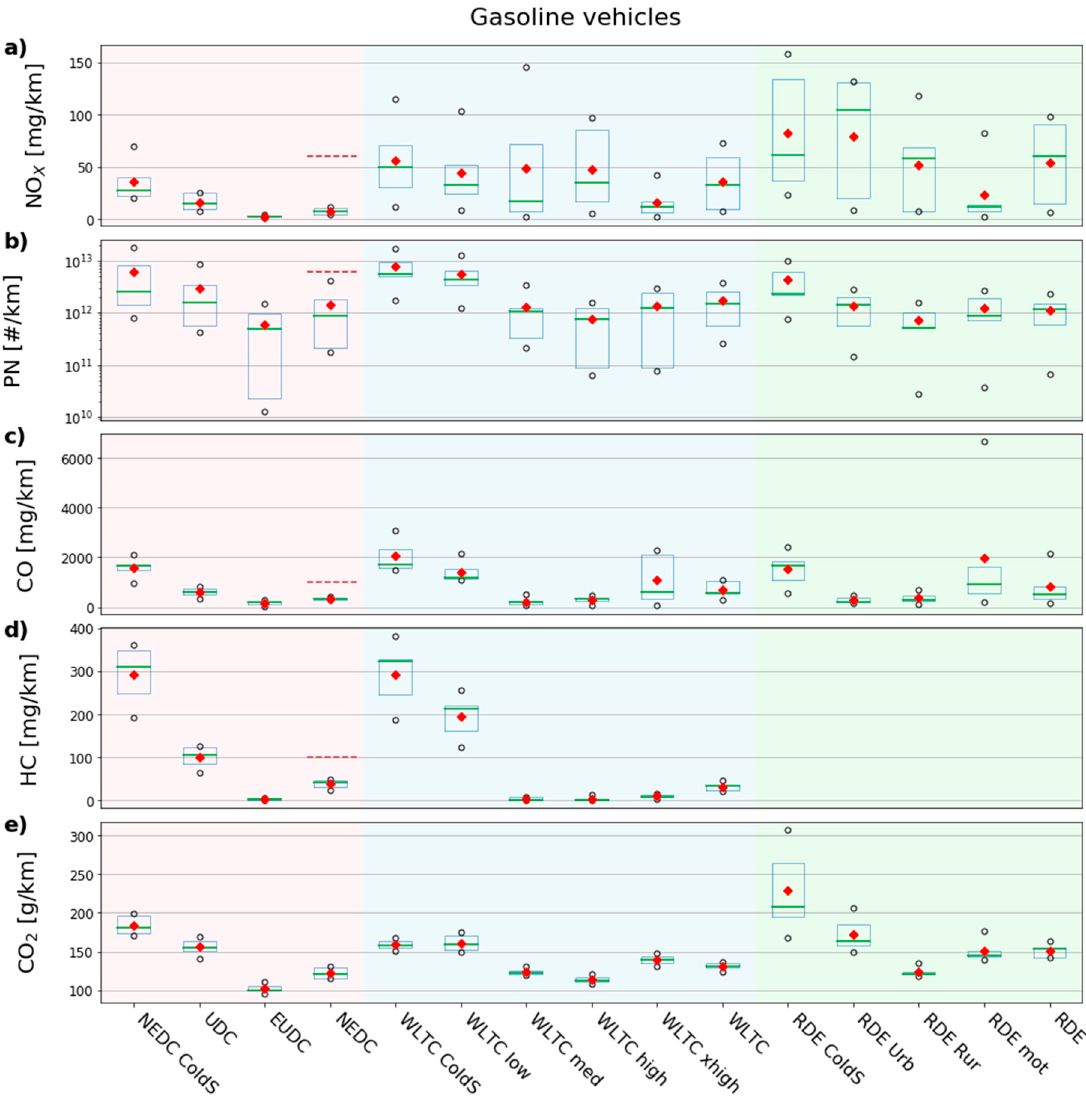
Figure 4. Boxplot of emission factors of the gasoline sample for NEDC, WLTC, and RDE phases and their respective cold start ( a ) NO X [mg / km], ( b ) PN [# / km], ( c ) CO [mg / km], ( d ) HC [mg / km], and ( e ) CO 2 [g / km]. The box represents the 1st and 3rd quartile, the green line is the median, the red diamond is the mean, and the black circles are data points beyond the interquartile range. The brown dashed lines represent the Euro 6 emission limit at type approval for gasoline vehicles over the NEDC cold test for NO X [60 mg / km], PN [6 × 10 12 # / km applicable for GDIs of this study], CO [1000 mg / km], and HC [100 mg / km]. Note that in ( b ) y -axis is logarithmic.